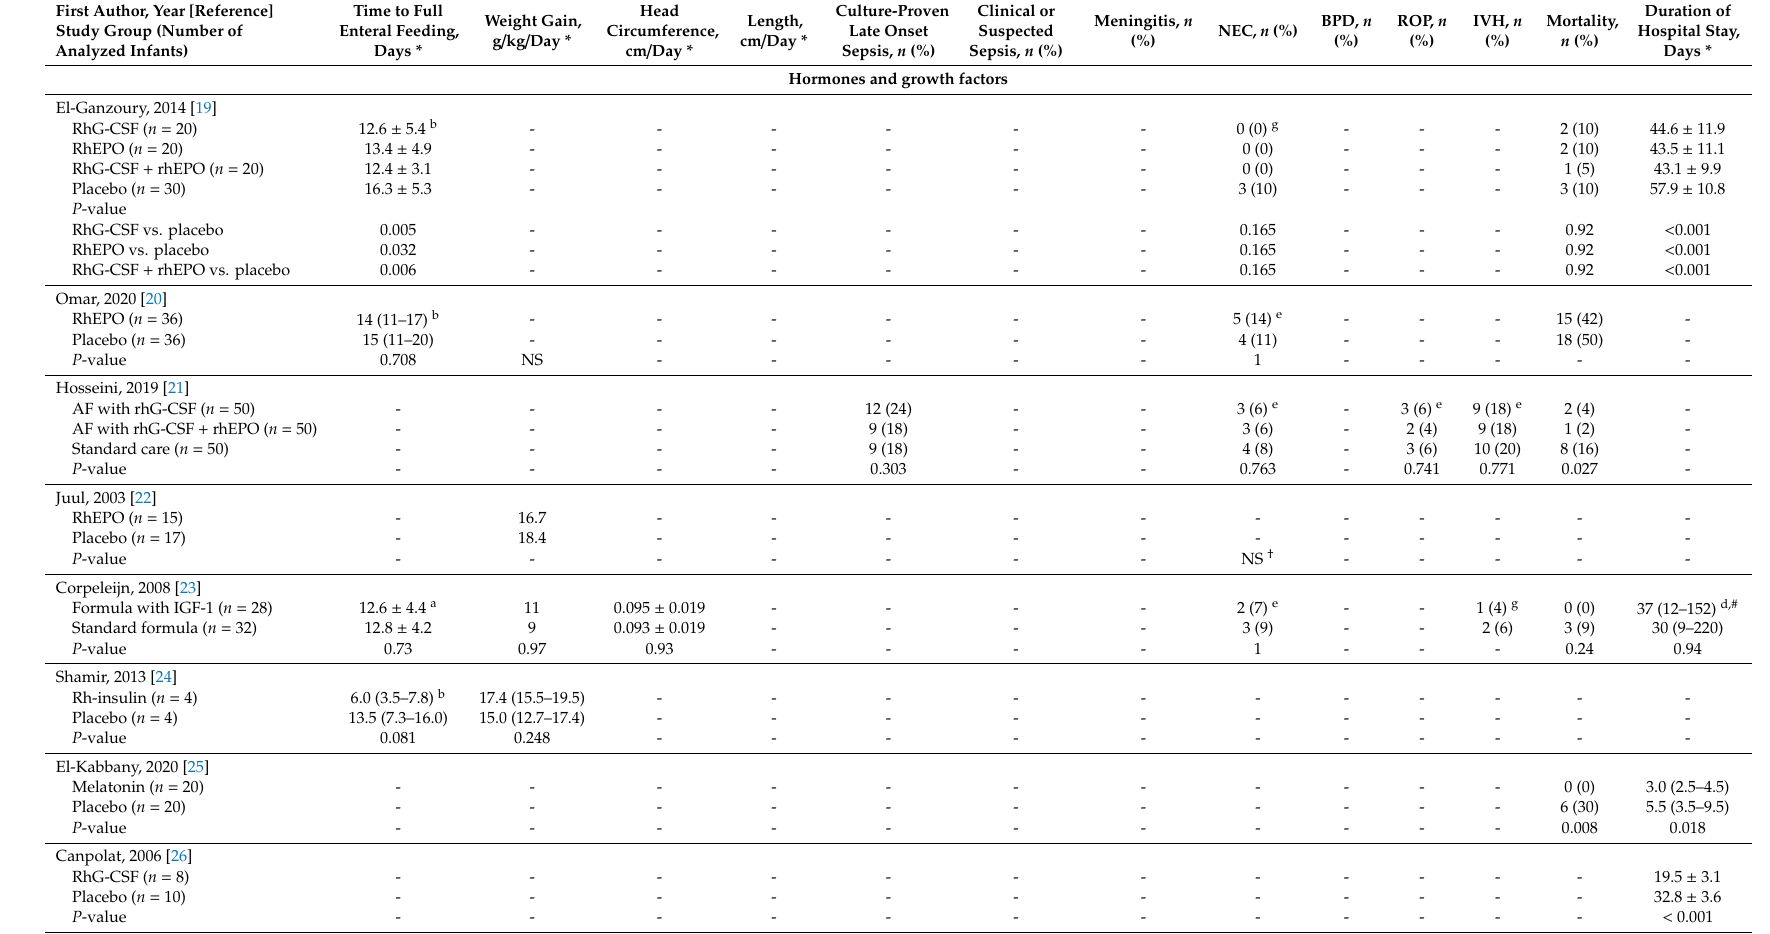
Table 2. E ff ects of supplemental enteral bioactive factors in preterm